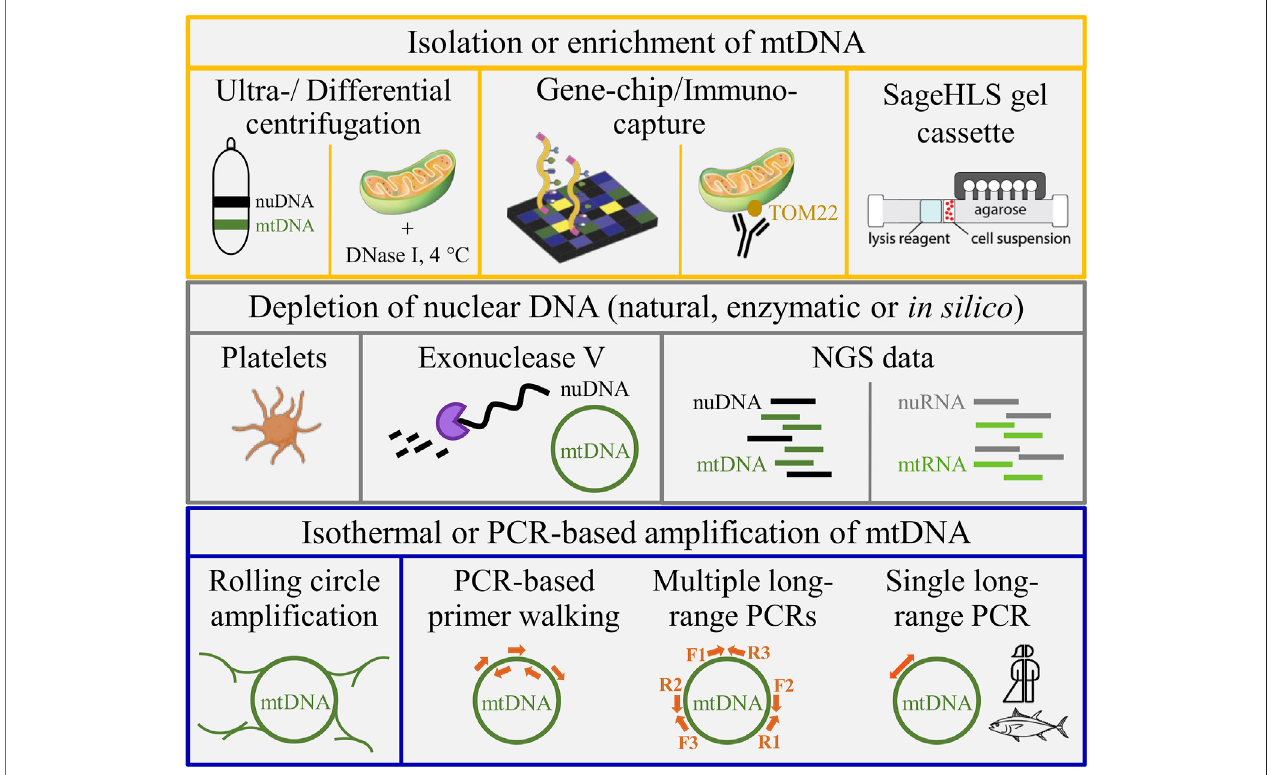
FIGURE 1 | Alternative approaches for mtDNA enrichment. Upper panel from left to right: CsCl gradient ultracentrifugation, isolation of native mitochondria with nucleolytic removal of surrounding nuclear DNA (nuDNA) contamination, mtDNA capture using a gene chip, TOM22-based immunocapture, and automated extraction of mtDNA in a proprietary agarose gel cassette (SageHLS ™ system; Sage Science, Beverly, MA, United States). Central panel from left to right: natural depletion of nuDNA(plateleticonfromwww.biorender.com),enzymatic(exonuclease)depletionofnuDNA,andjointsequencingofnuDNAandmtDNAornuclearRNA(nuRNA) and mitochondrial RNA (mtRNA) by NGS analysis (DNA or RNA sequencing, respectively). Bottom panel from left to right: rolling-circle ampli fi cation, primer walking, several long-range PCRs to cover the mitogenome (F & R: ampli fi cation primers), and single-amplicon long-range PCR with back-to-back primers that was extended within this study beyond application in humans (symbolized by the gender-neutral person icon) and ray- fi nned fi shes (class Actinopterygii ).